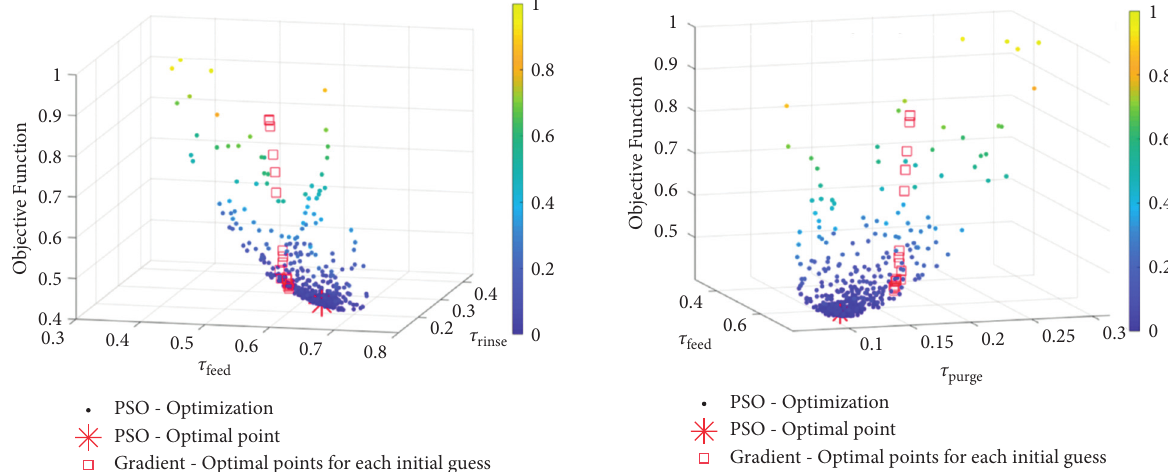
Figure 9: Results of the objected function for the combinations of different